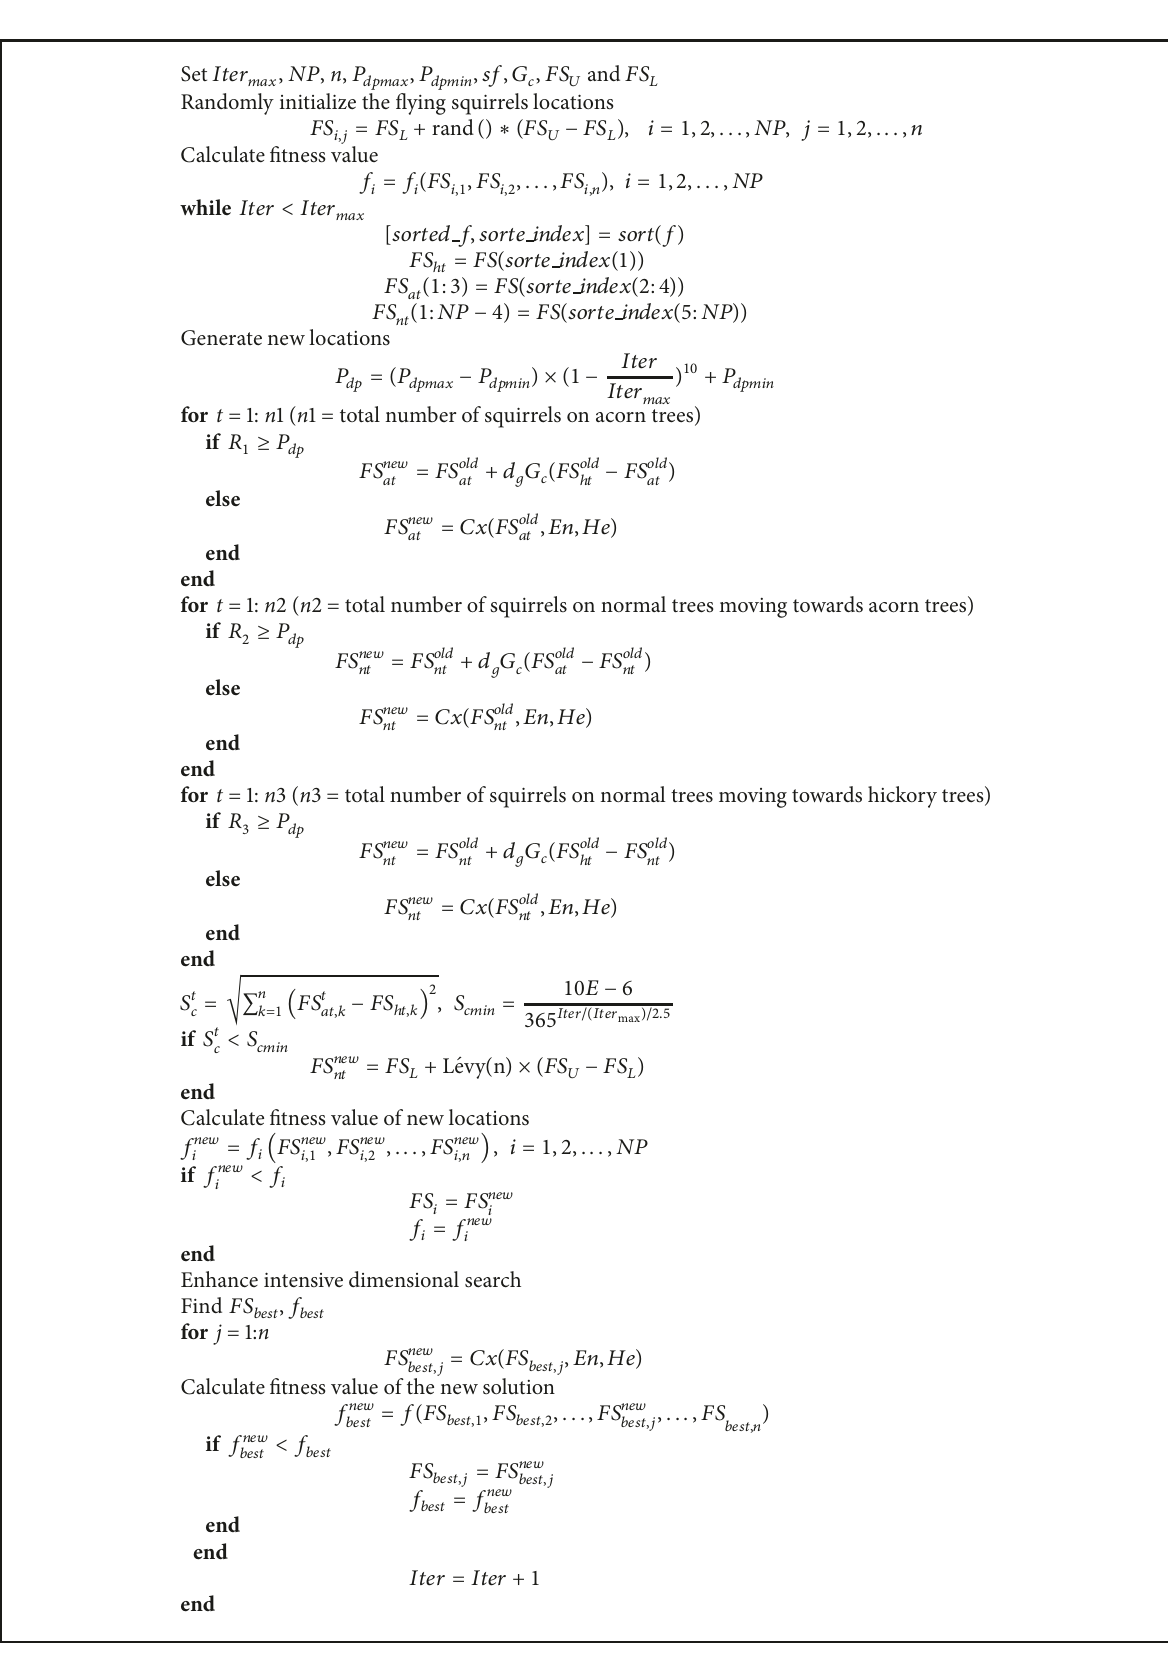
Algorithm 2: Pseudocode of basic